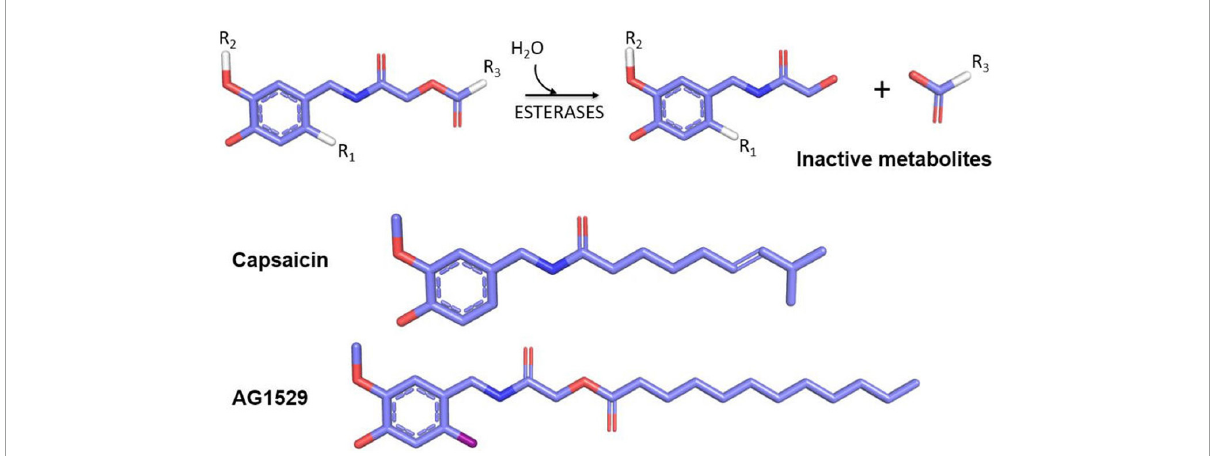
FIGURE5 Soft drugs derived from capsaicin (upper part) have an ester bond sensitive to hydrolysis by skin esterases that produce an inert and easily disposable metabolite (vanillylacetamide) and a lipid that can be assimilated by cells. The inclusion of an iodine atom at the R1 position generates TRPV1 antagonists, and positions R2 and R3 may be used to increase the library chemical diversity. In the lower part, the comparative chemical structures between capsaicin and the selected AG1529 for further clinical development are